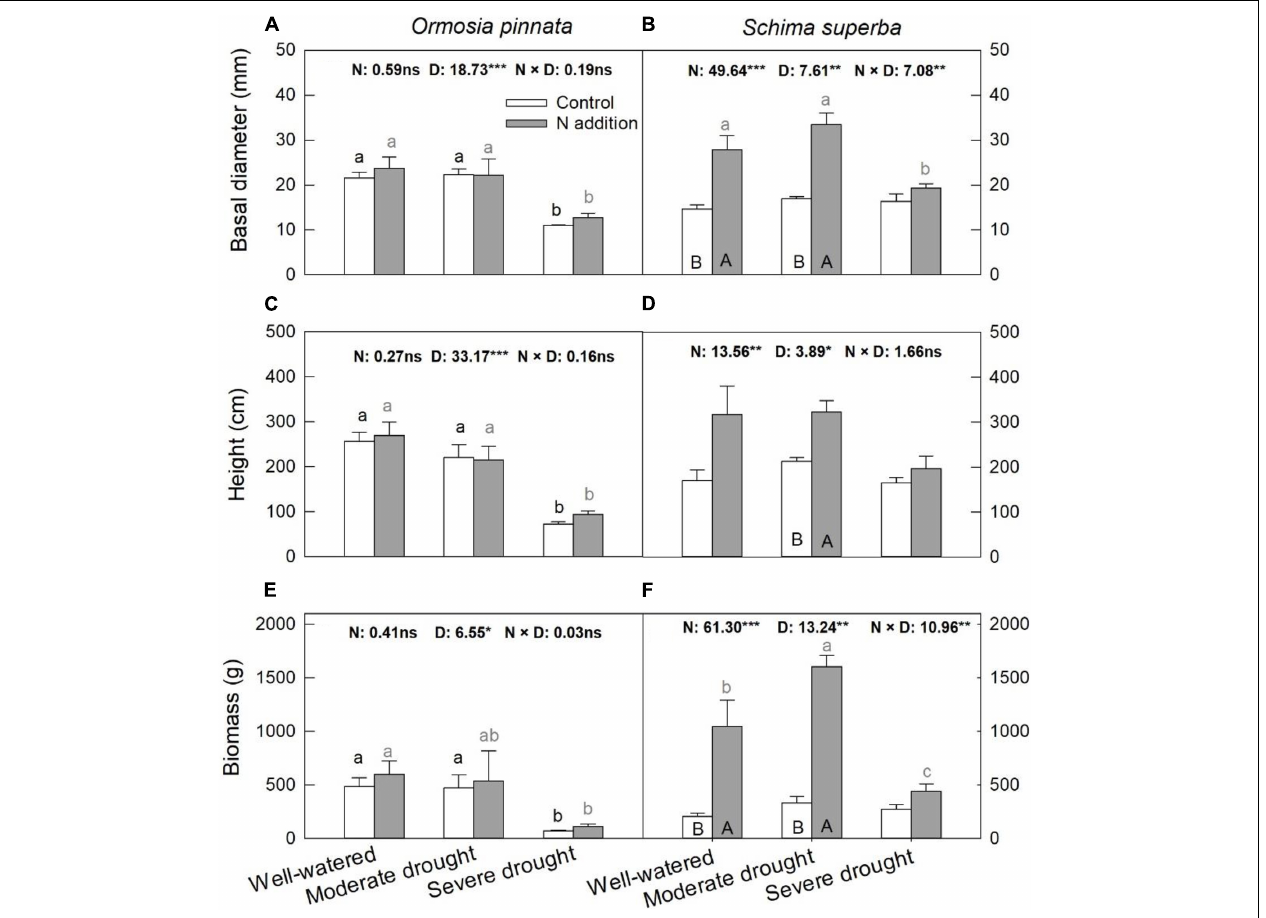
FIGURE 2 | Responses of basal diameter (A,B) , height (C,D) , and biomass (E,F) of O. pinnata and S. superba to different watering and N addition treatments. Bars show means ± SE ( n = 3). Different lowercase letters above bars indicate significant differences among three watering regimes within each N addition rate. Different capitalized letters below bars indicate significant differences between control and N addition within each watering regime. F -values of the two-way ANOVA of nitrogen (N), drought (D), and their interactions (N × D) are indicated. * P < 0.05; ** P < 0.01; *** P < 0.001; ns, not significant.